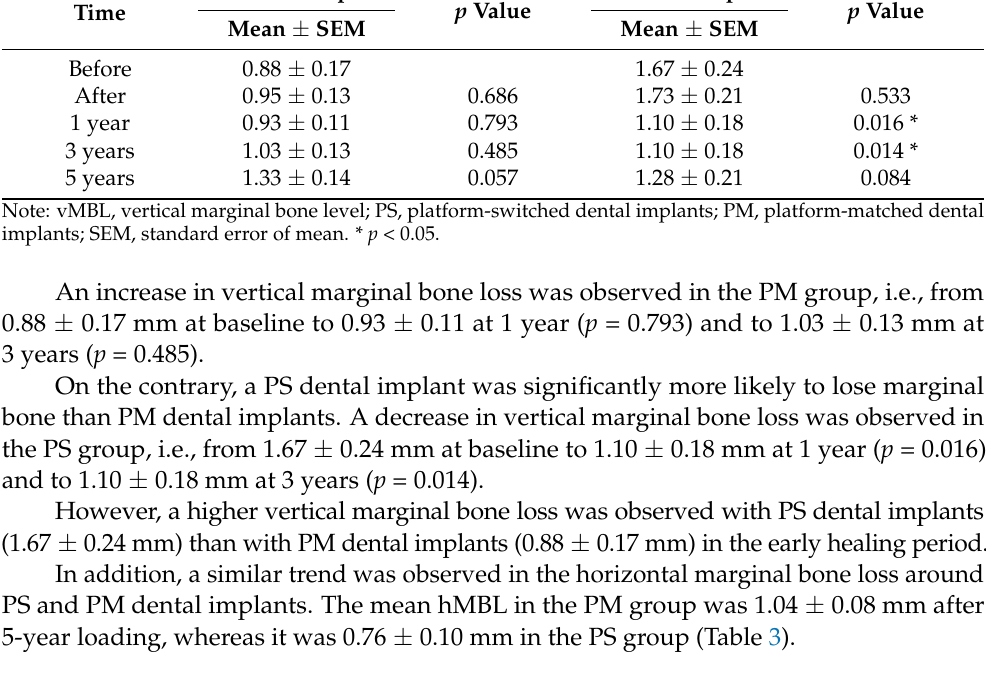
Table 3. Mean hMBL outcomes of the PM and PS